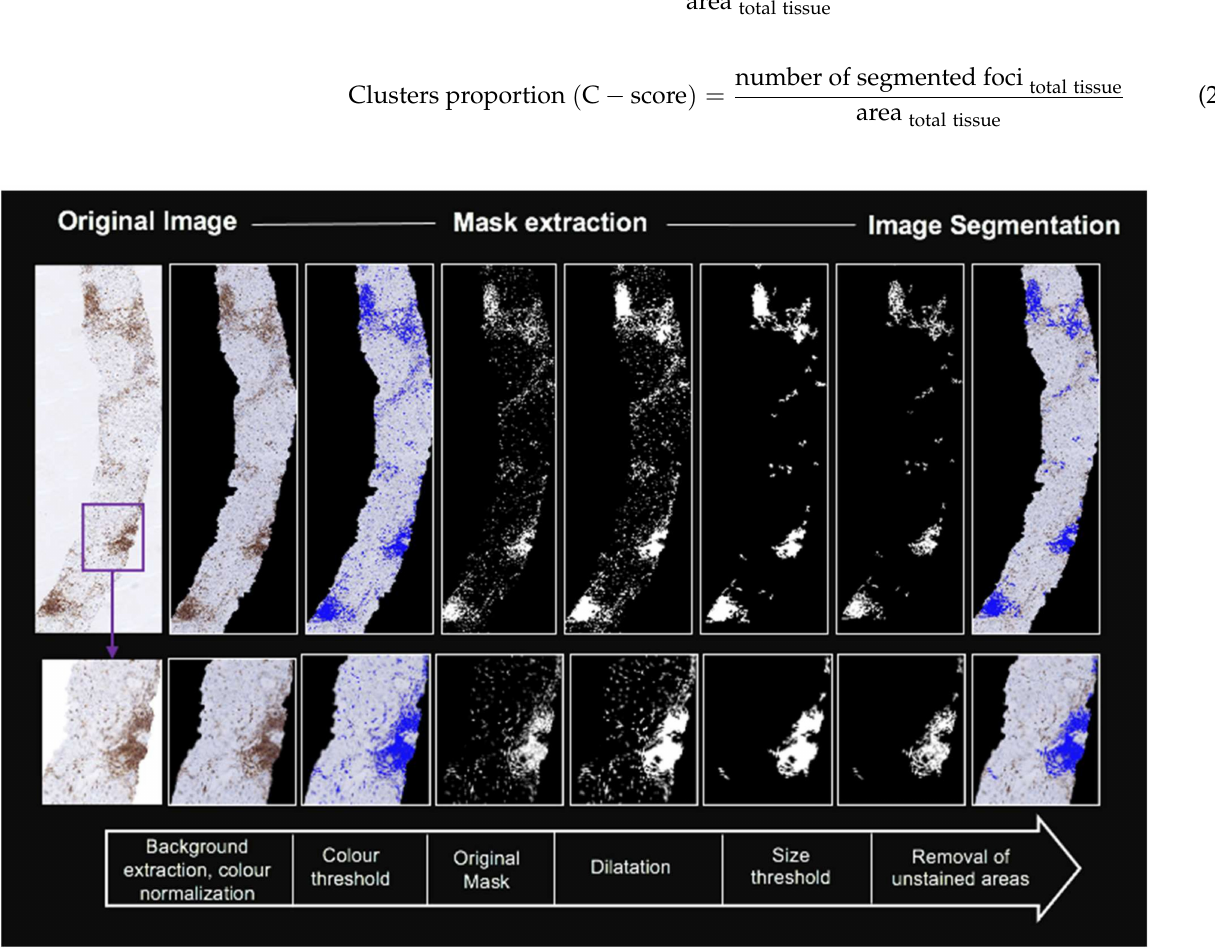
Figure 1. Digital image analysis workflow in a biopsy specimen with NASH diagnosis. Mask extraction was based on colour detection, size threshold, and morphological analysis. Bottom row shows a small region of interest to display details of the image processing algorithm, although the analysis was performed on the whole slice. Image segmentation of the represented case determined inflammation proportional area (I-score: 4.9% CD45+) and clusters proportion (C-score: 12.2 foci/mm 2